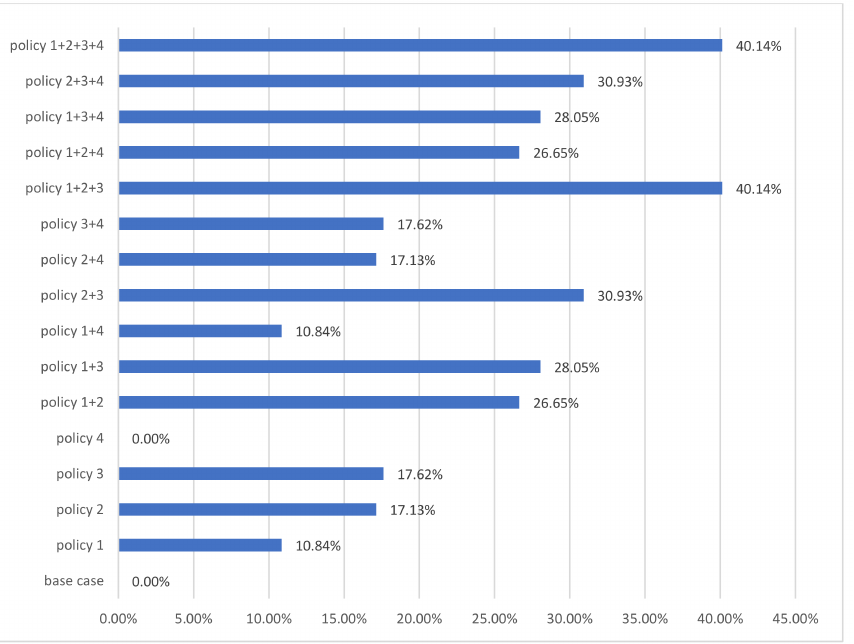
Figure 8. The effect of policy measures on resource consumption by policy measures until